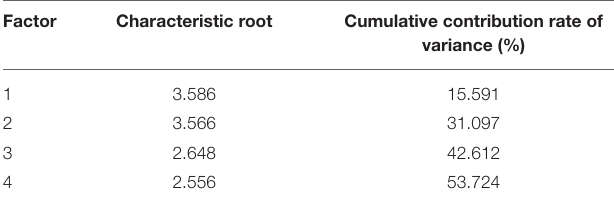
TABLE 3 | Test results of factor characteristic roots, variance contribution rate, and variance cumulative contribution rate.